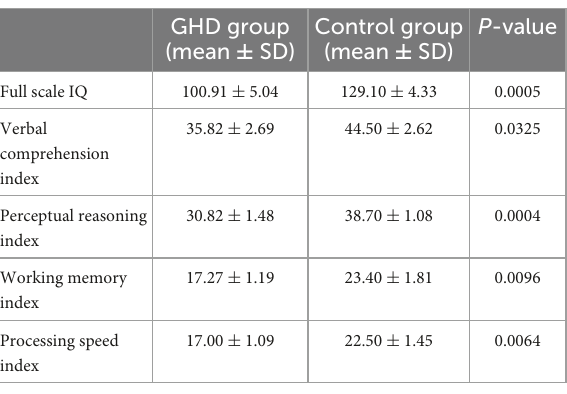
TABLE 2 Neuropsychological assessment scores in two